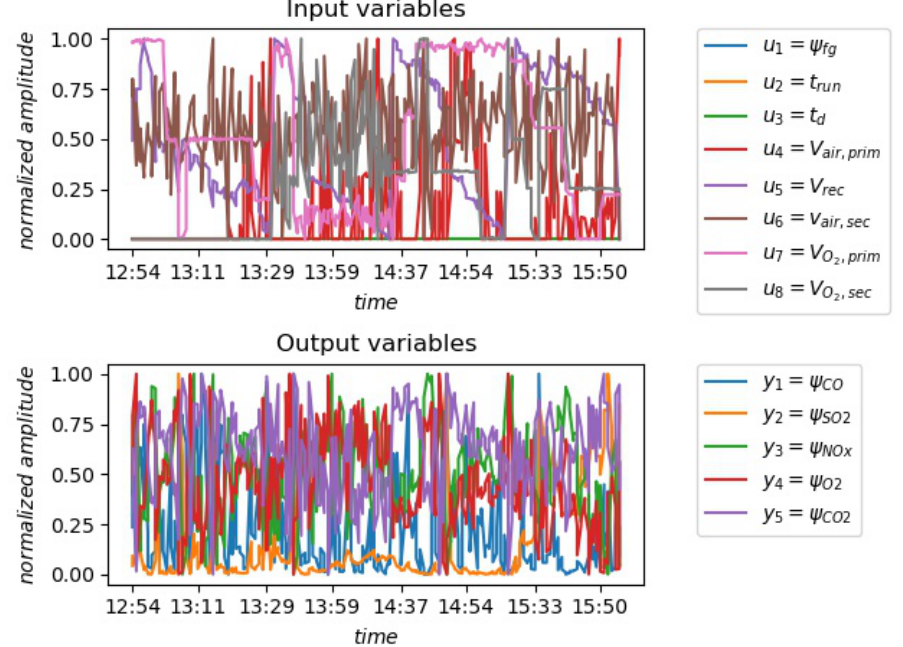
Figure 3. Snapshot of normalized, preprocessed data from one of the real experiments, u i are process input variables and y i are process output variables described in Table